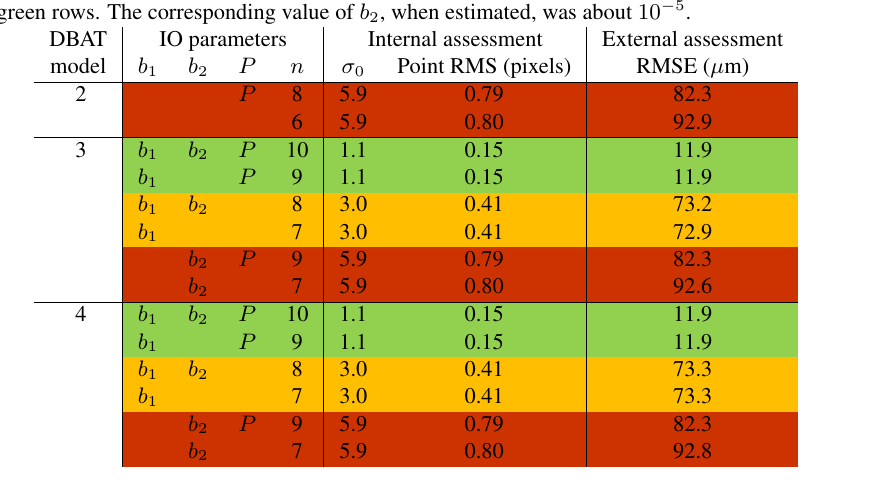
Table 2: Assessment of DBAT estimation models 2, 3, and 4 on the real-world data set. The IO parameters and assessment are as in Table 1, except that the target coordinates computed from the N ORMAL data set was used as the true data. The estimated b 1 value was about 0.0019 for all green rows. The corresponding value of b 2 , when estimated, was about 10 − 5 .